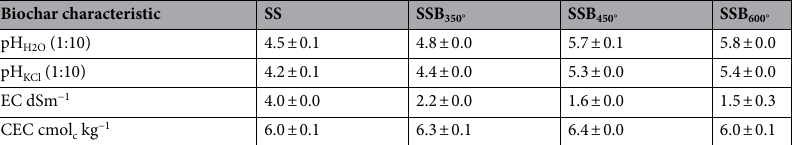
Table 2. Physical–chemical characteristics of sewage sludge (SS) and sewage sludge biochars (SSB) produced at 350 (SSB 350 ), 450 (SSB 450 ) and 600 (SSB 600